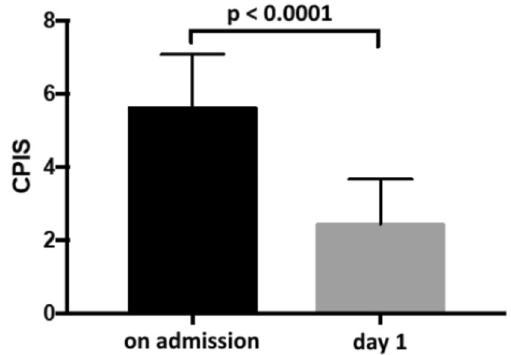
Fig. 1 Modifications in Clinical Pulmonary Infection Scores (CPIS) from admission, to day 1 of follow‑up in seawater drowned patients admitted to the ICU. Scores were compared using a Student’s paired T‑test F‑021 Impact of Extra‑Corporeal Membrane Oxygenation (ECMO) support